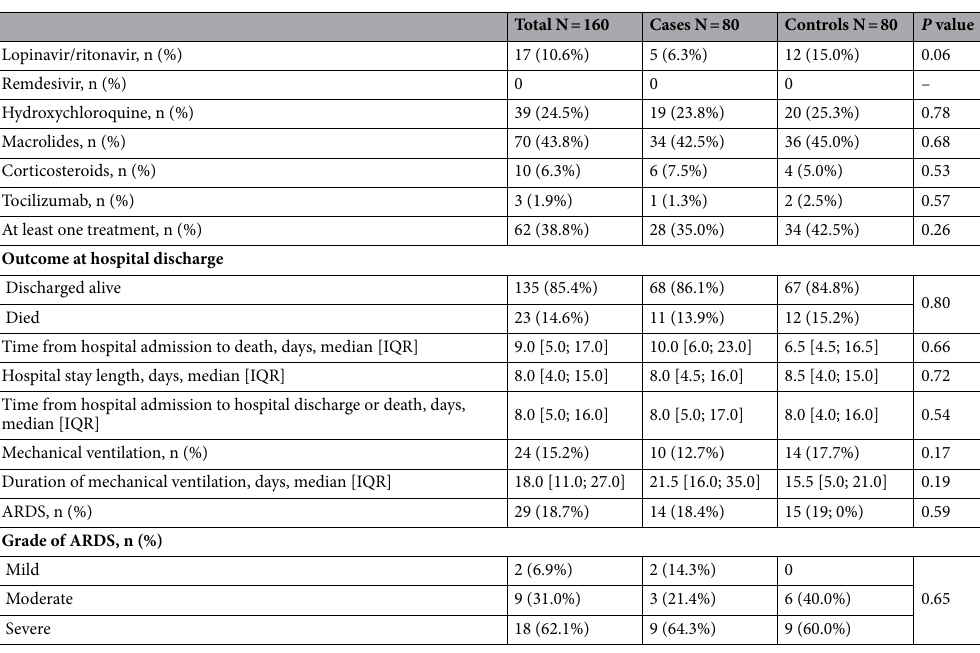
Table 3. Treatments and outcomes. IQR interquartile range, ARDS acute respiratory distress